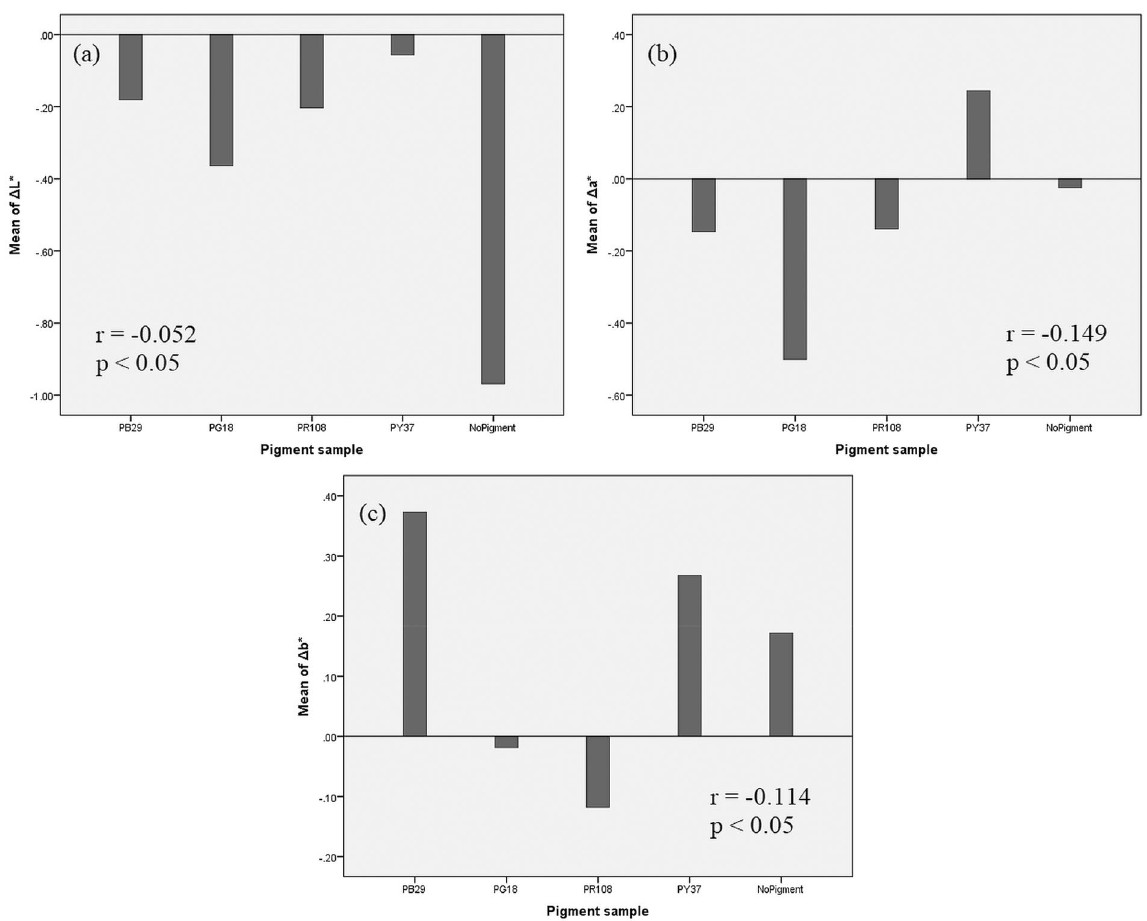
Figure 6. Correlation between colour change (mean of ΔE) and pigment type used for the samples (PB29 = ultramarine blue/PG18 = chrome green/PR108 = cadmium red/PY37 = cadmium yellow), and binders without pigments (NoPigment): along CIELAB ( a ) L*, ( b ) a*, and ( c ) b*